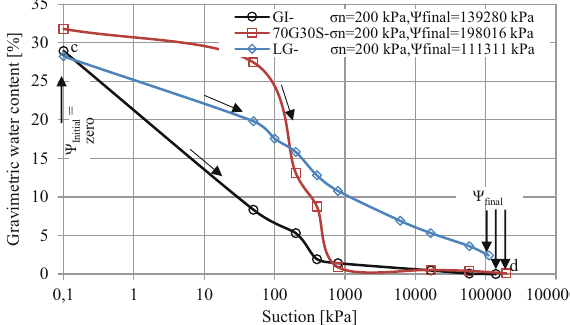
Figure 12: Variation of the gravimetric water content with suction of the ( CN - SI ) drying